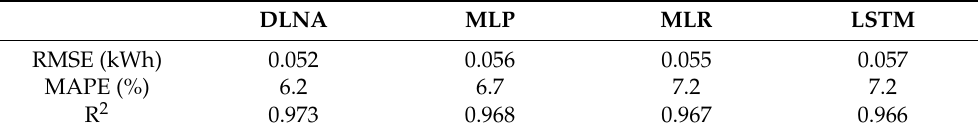
The RMSE error for sequences 501 to 600 is 0.052 kWh. Table 4. MAPE and RMSE errors for all tested prediction models.